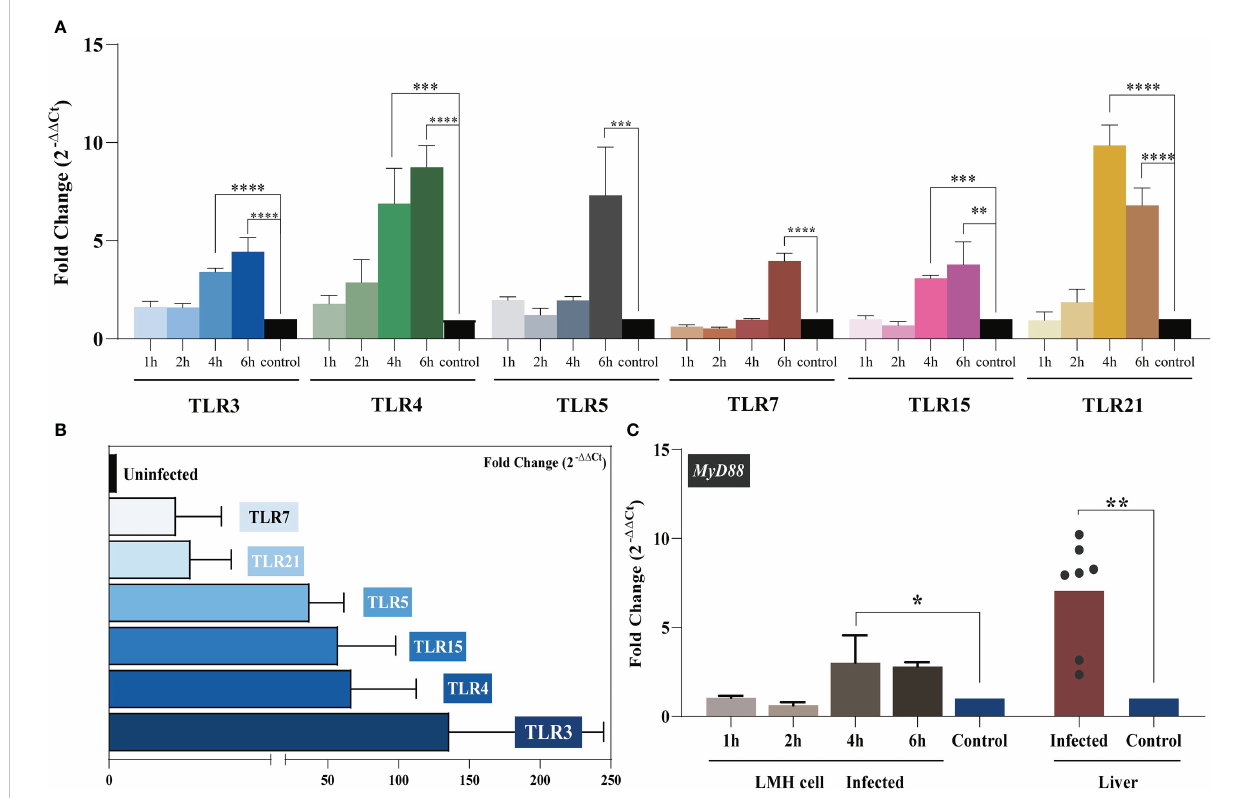
FIGURE 2 TLR mRNA expression after YT strain infection in vitro and in vivo . (A) The relative mRNA levels of TLRs in LMH cells. The mRNA level of TLRs increased as infection time increased. The infected group and the control group are represented in blue, green, gray, red, pink, yellow, and black, respectively. (B) The relative mRNA levels of TLRs in liver tissue. (C) MyD88 expression in LMH cells and SPF chickens. Symbols indicate comparison versus control group; *P < 0.05, **P < 0.01, ***P < 0.001 and ****P <